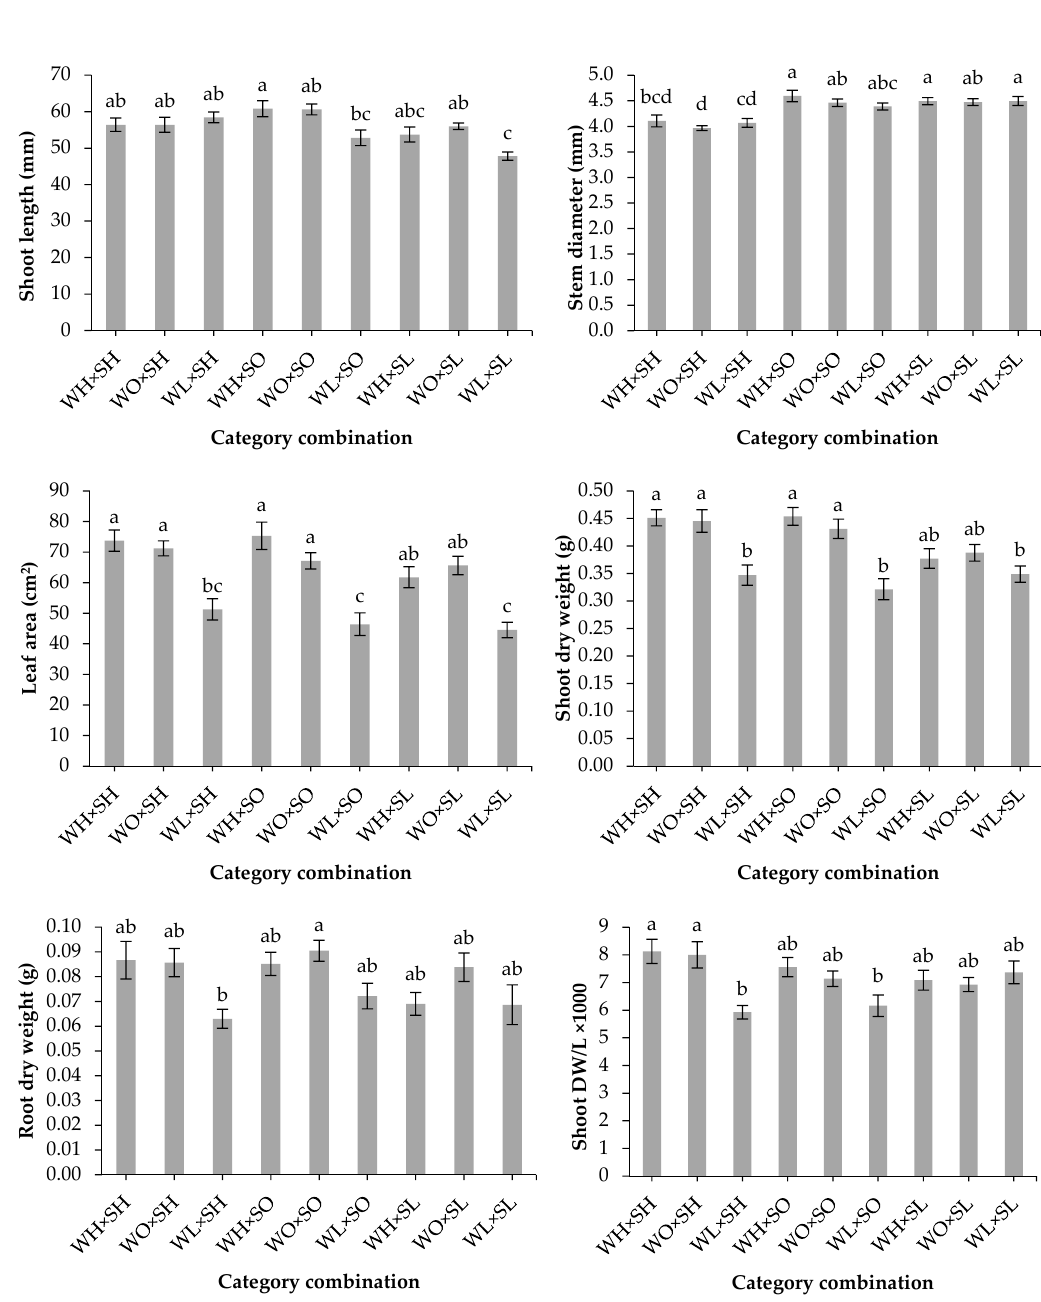
shoot dry weight-to-length ratio. Bars followed by different letters are significantly different ( α ≤ 0.05). Each mean value was computed from n = 12 seedlings. Error bars correspond to the standard error (SE) of the mean.